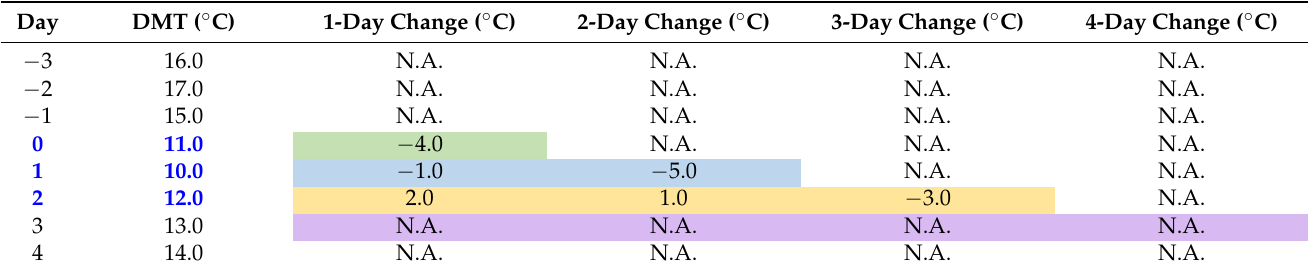
Table 3. An example of how ∆ T is defined using a hypothetical 3-day cold event (Day 0 to Day 2, text highlighted in blue). In the case: 1-day Change = the entry highlighted in green = − 4 ◦ C; 2-day Change = the minimum of entries highlighted in green and blue = − 5 ◦ C; 3-day Change = the minimum of entries highlighted in green, blue and orange = − 5 ◦ C; 4-day Change = the minimum of entries highlighted in green, blue, orange and purple = − 5 ◦ C.